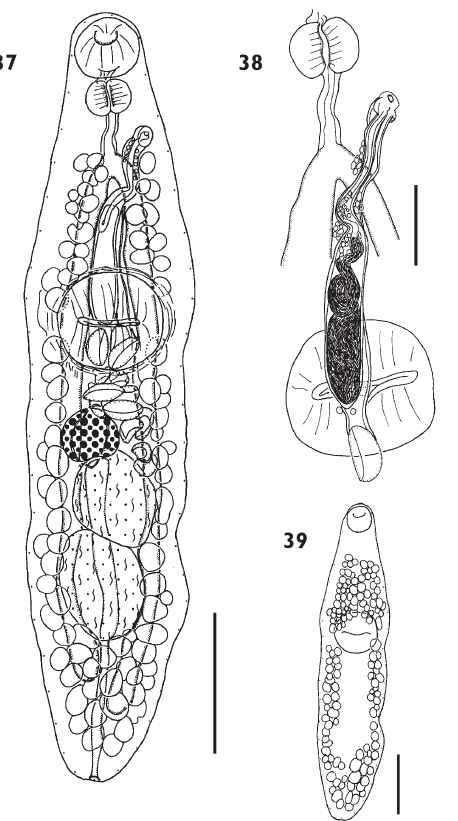
Figs 37-39. Macvicaria kingscotensis n. sp. ex Neoodax balteatus . 37. Whole-mount ventral view. 38. Terminal genitalia. 39. Dorsal distribution of vitelline follicles. Scale bars : 37, 39, 250 μm; 38, 100